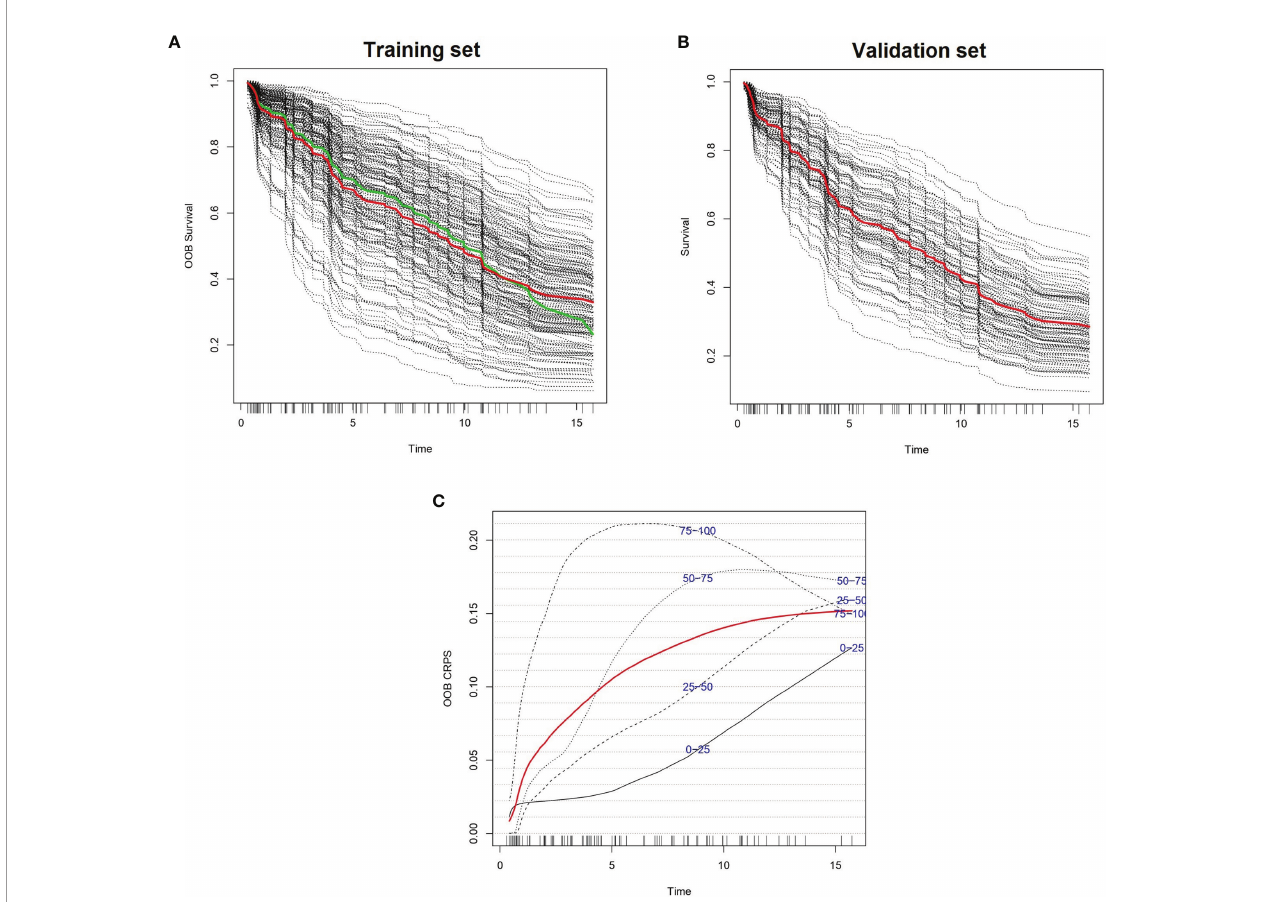
FIGURE 1 | Predicted individual survival curves according to the most accurate random forest model (see text). (A) Out-of-bag survival curves predicted for patients within the training cohort (discontinuous black lines). The thick red line represents overall ensemble survival and the thick green line indicates the Nelson-Aalen estimator. (B) Individual survival curves predicted for patients within the test cohort (discontinuous black lines). The thick red line represents overall ensemble survival. Time scale is in years. (C) Representation of out-of-bag CRPS over time. Red line is the overall CRPS. Additionally, strati fi ed CRPS by quarters of predicted ensemble mortality are provided. Vertical lines above the x axis represent death events.